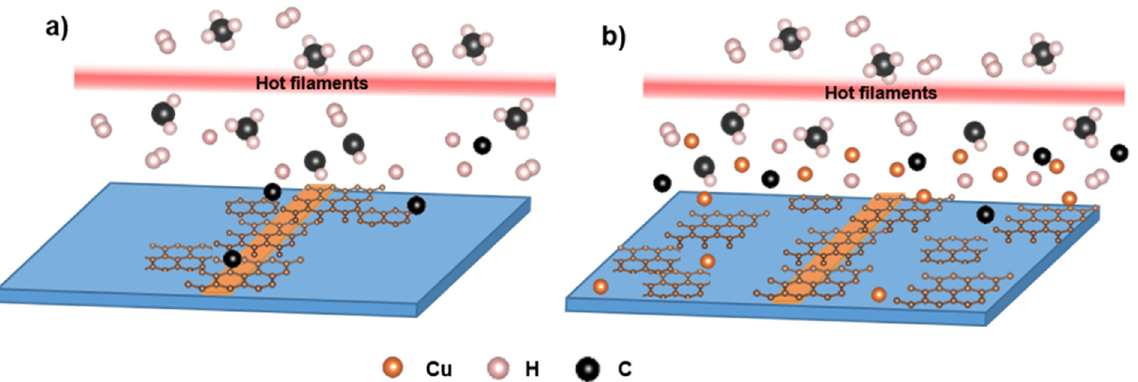
Figure 8. Schematic of the graphene growth mechanism on SiO 2 /Si substrate. ( a ) graphene migration from the copper-strip film and ( b ) the catalytic effect of the copper vapor to form graphene. In both figures, CH 4 /H 2 molecules pass through the hot filaments prior to deposition. For more detail on the mechanism, see text.